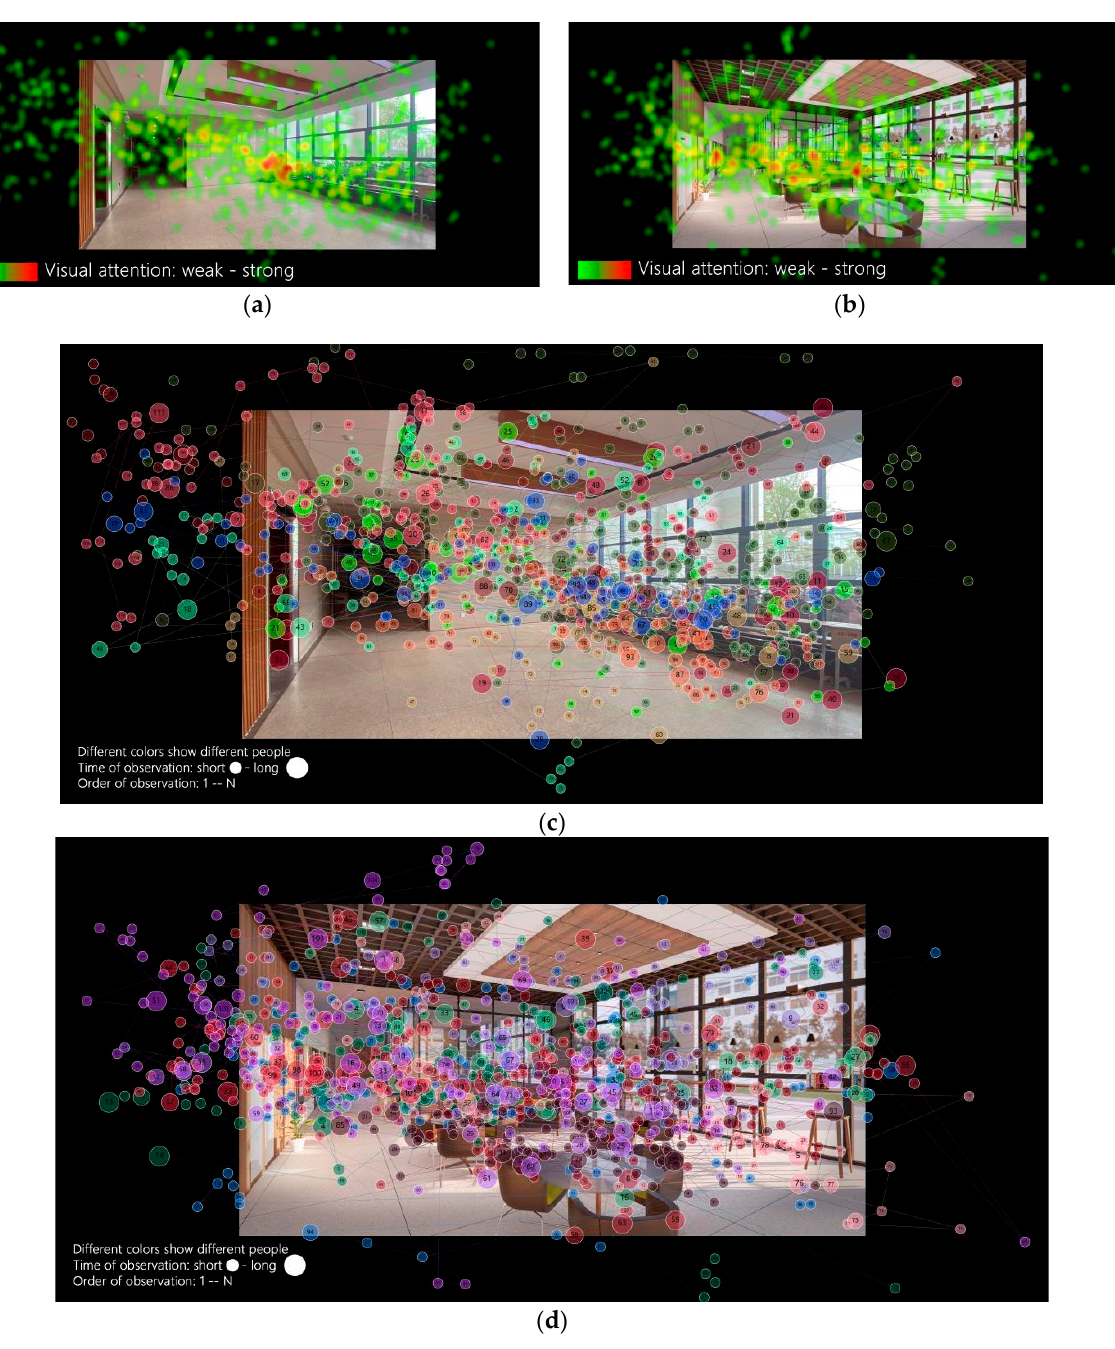
Figure 8. Distribution of eye-tracking data of the first-floor cafe. ( a ) The heat map before optimization. ( b ) The heat map after optimization. ( c ) The gaze plots before optimization. ( d ) The gaze plots after optimization.